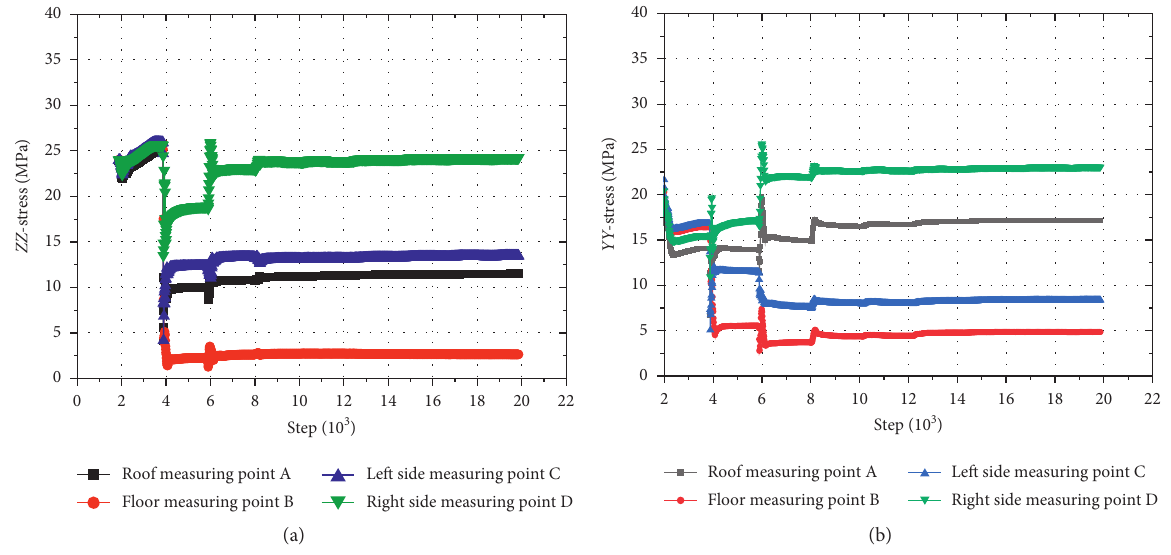
Figure 7: The stress curve at the measuring point: (a) horizontal stress; (b) vertical stress.